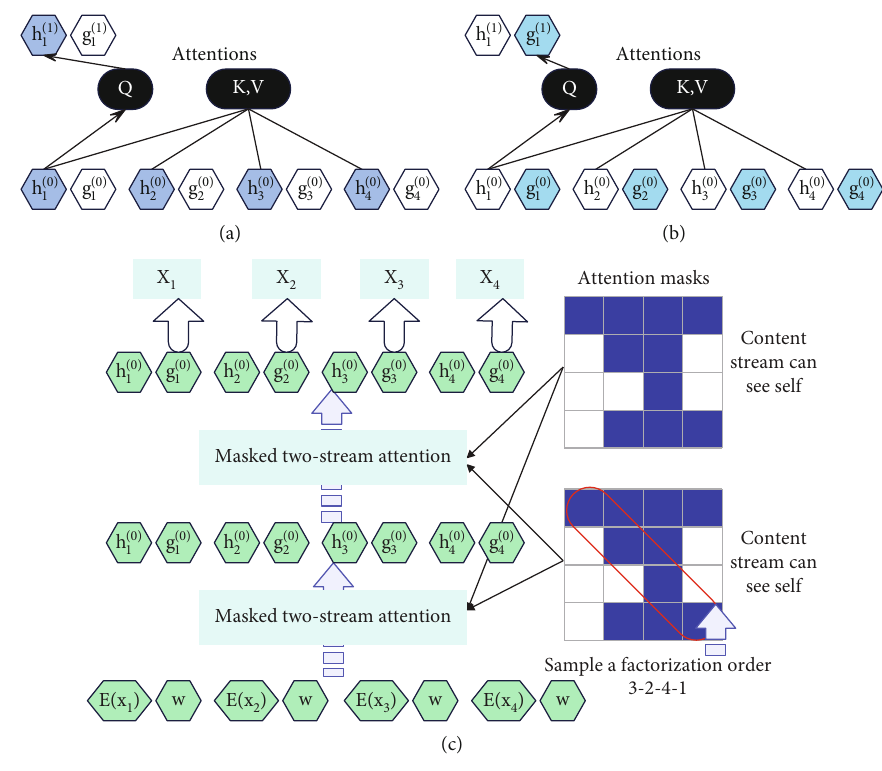
Figure 7: The structure of the dual-stream attention mechanism.